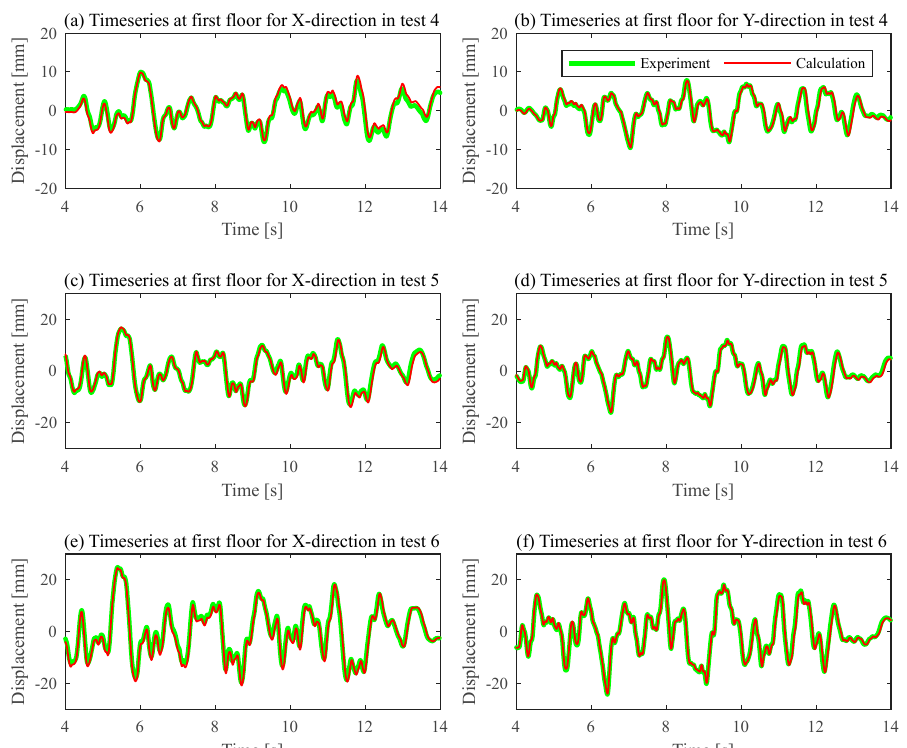
Figure 8. Comparison of displacements calculated using acceleration measured by reference accel- erometers and smartphones along the X and Y directions in tests 4 to 6.